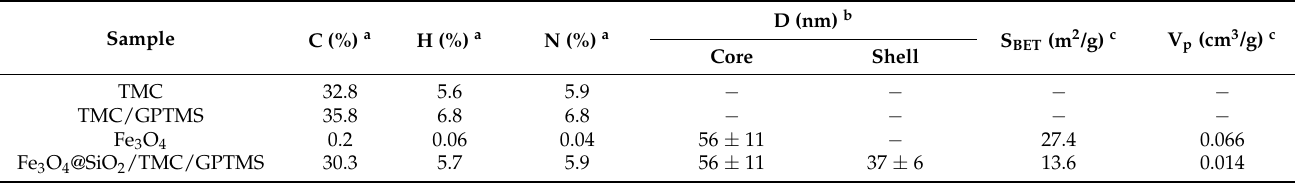
Table 1. Compositional and structural properties of the materials: elemental analysis, particle diameter, BET surface area, and pore